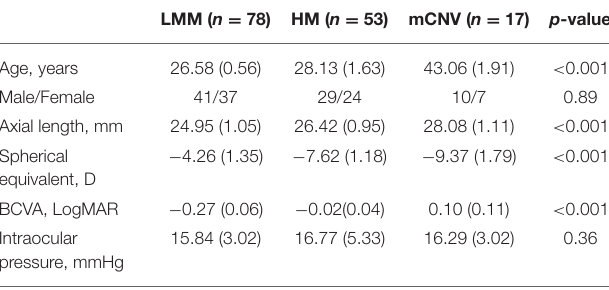
TABLE 1 | Baseline characteristics of study